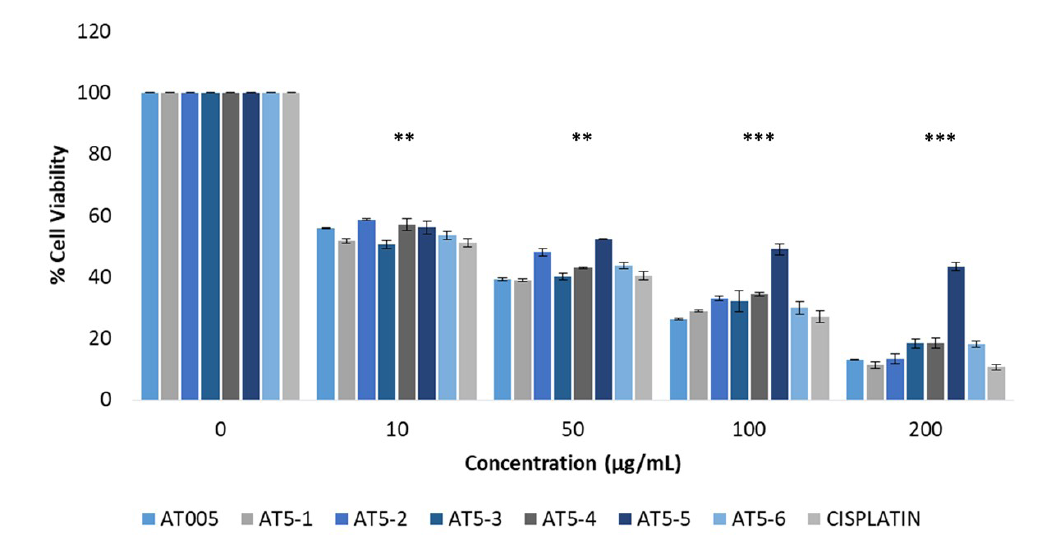
Figure 2. Concentration-dependent inhibition of A549 cells by P. bundokalbo venom fractions after 48-hour incubation period. Averaged data from three trials with triplicate readings are shown. ***Statistically different effect compared to the negative control, statistical difference between concentrations, and statistical difference between samples. **Statistically different effect compared to the negative control, and statistical difference between samples.